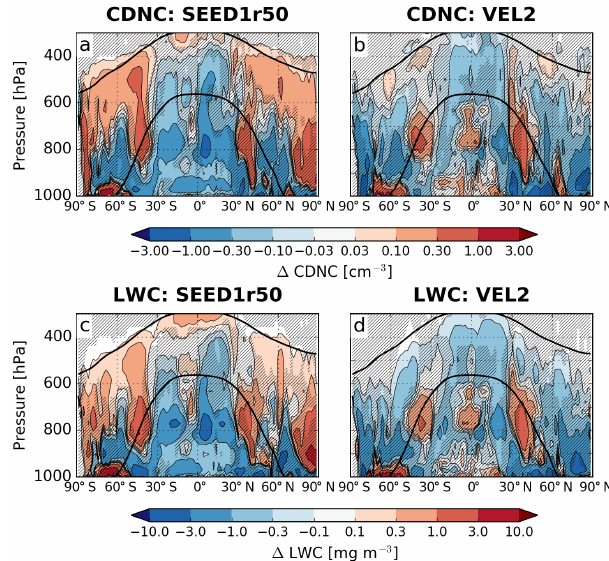
Figure 6. Annually averaged all-sky anomalies of the cloud droplet number concentration (CDNC, a, b ) and liquid water content (LWC, c, d ) for the SEED1r50 and VEL2 fixed SST simulations (see Ta- ble 1). The black curves are the − 35 ◦ C and the 0 ◦ C isolines. The hatching is applied for anomalies not significant at the 95% confi- dence